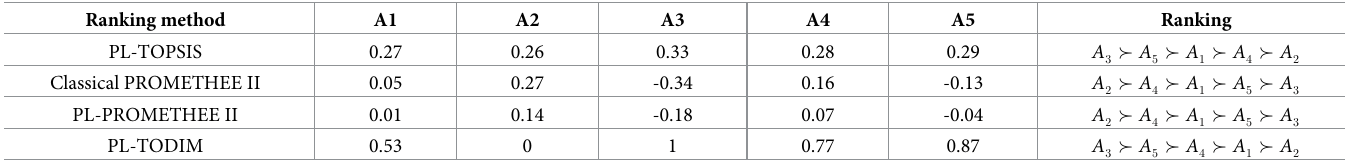
Table 20. The results based on the comparing methods. Ranking